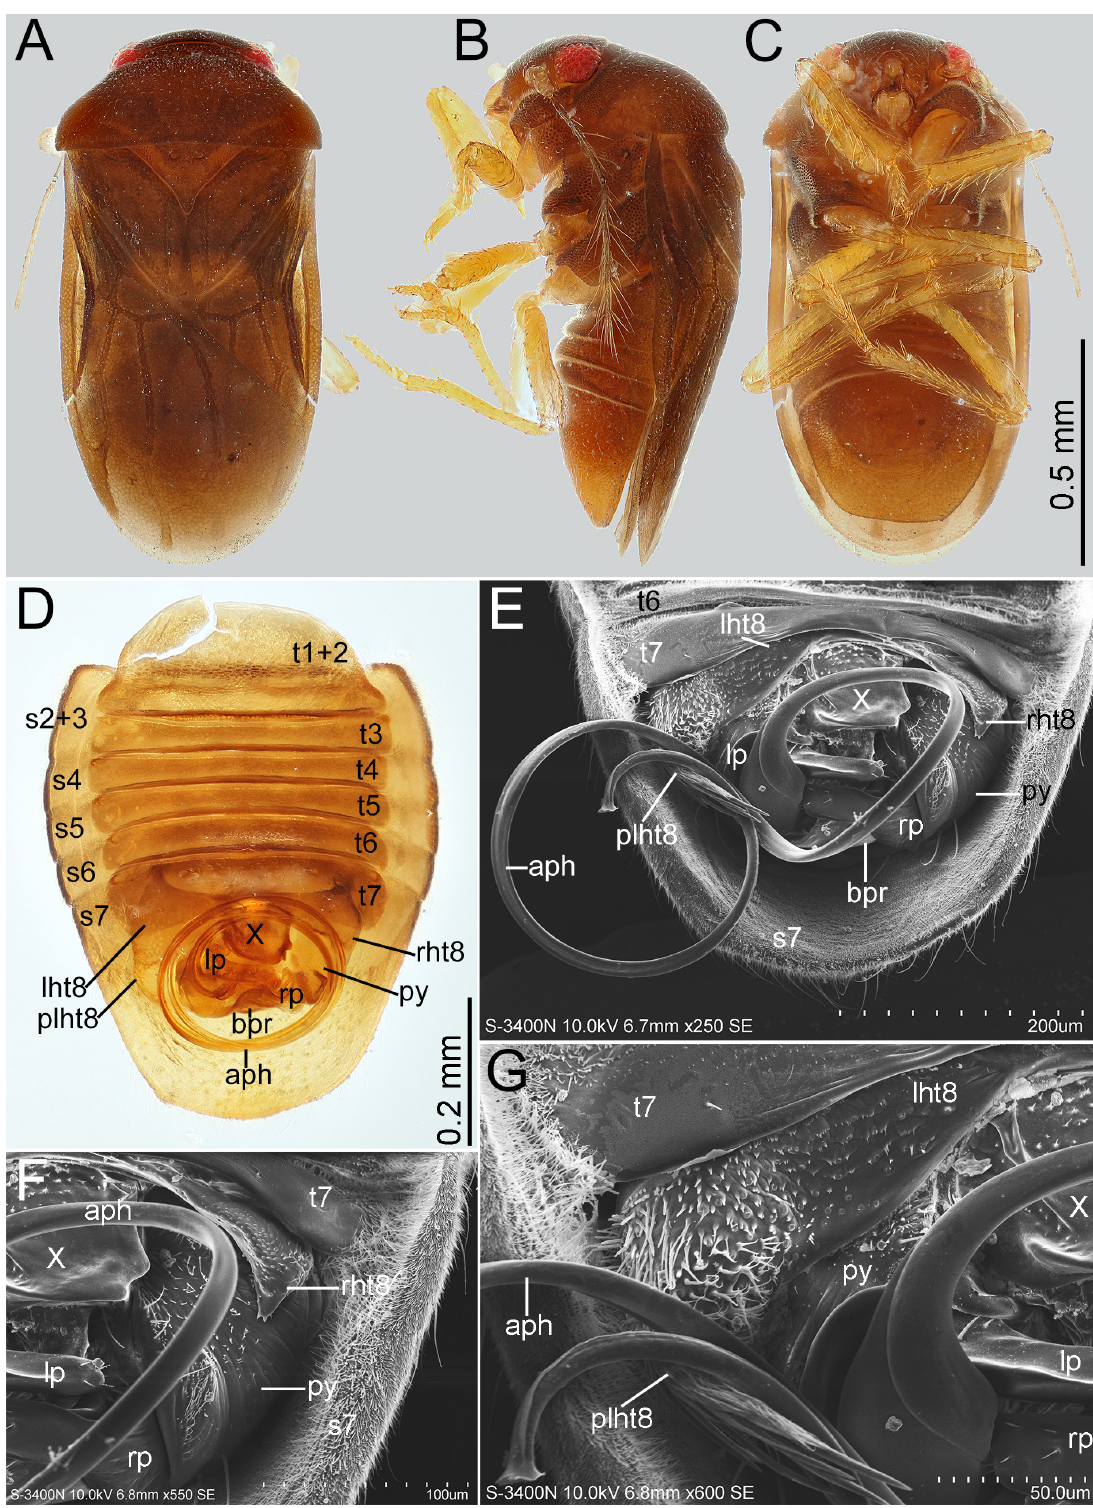
Fig. 21. Kokeshia weirauchae sp. nov. A‒C . Habitus, holotype, ♂ (NKUM). A . Dorsal view. B . Lateral view. C . Ventral view. D . Pregenital abdomen and genitalia, dorsal view, paratype, ♂ (SYSBM). E‒G . Scanning electron micrographs of genitalia, paratype, ♂ (SYSBM). E . Dorsal view. F . Right side, dorsal view. G . Left side, dorsal view. Abbreviations: see Material and